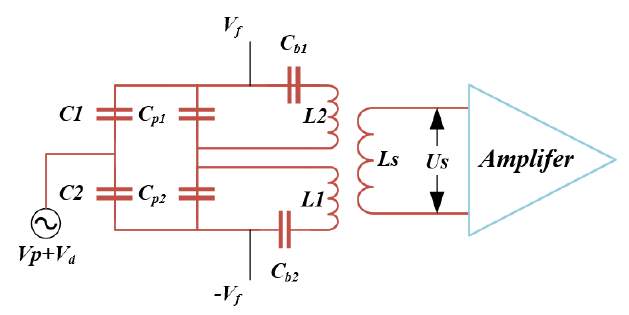
Figure 8. Schematic of the capacitor bridge. Table 2. Capacitances and inductances